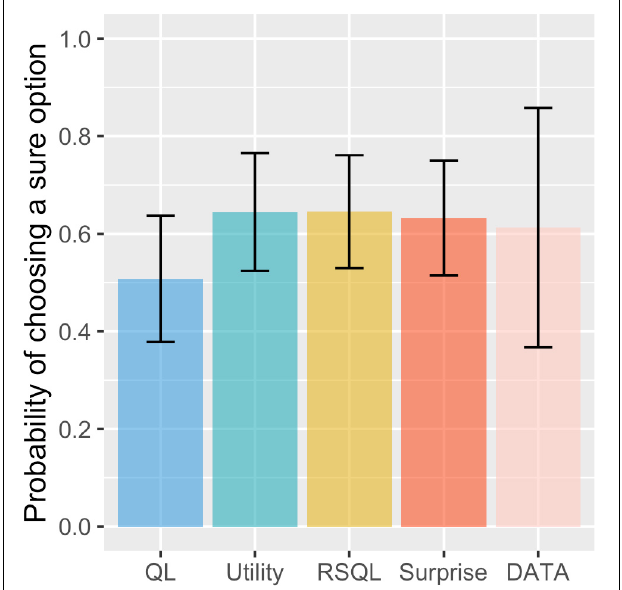
FIGURE 1 | Probability of choosing a sure option for model and real data. Data are presented as the mean ± standard error. The surprise-sensitive utility model had a similar probability of choosing a sure option (risk aversion) as the risk-sensitive Q-learning model and the utility model. Additionally, the probability of choosing a sure option simulated with the proposed model was similar to the result of real experimental data. QL, Q-learning model; utility, utility model; RSQL, risk-sensitive Q-learning model; surprise, surprise-sensitive utility model.